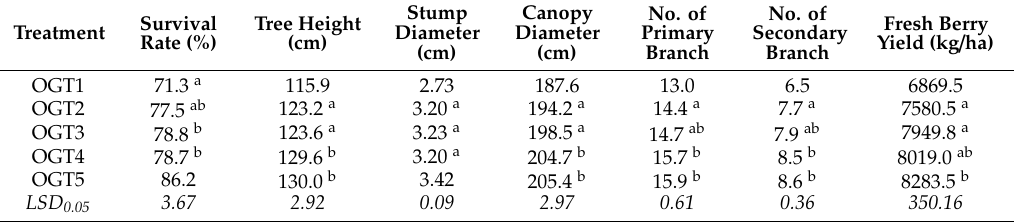
Table 4. Survival rate, growth rate and fresh berry yield by organic treatments.